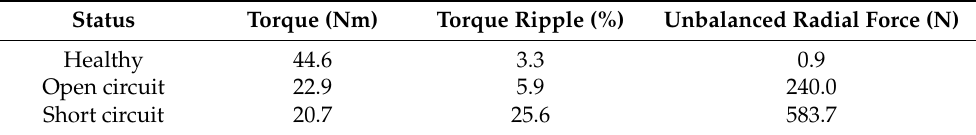
Table 8. The fault tolerance (FT) evaluation of dual three-phase